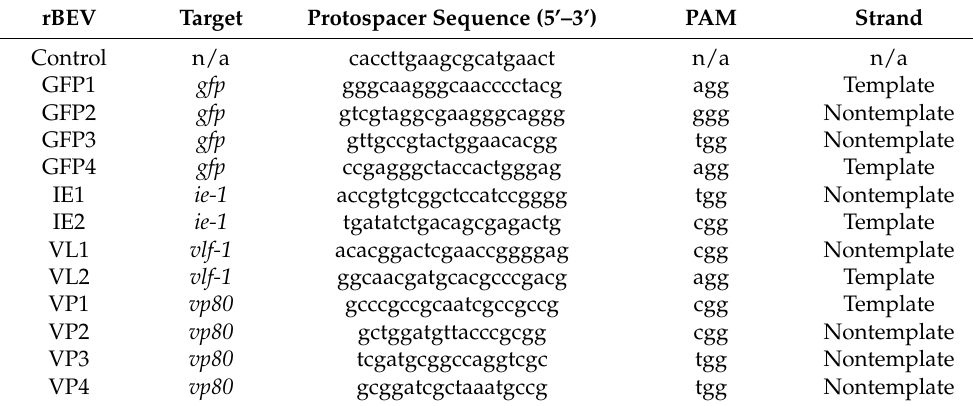
Table 1. Protospacer sequences for sgRNA